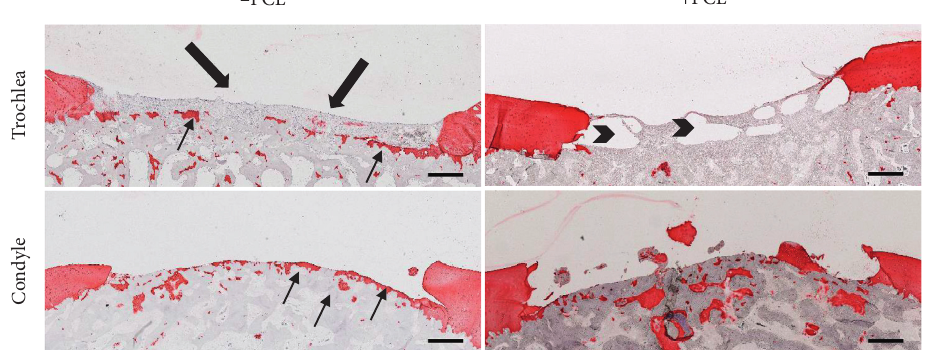
Figure 3: Insufficient construct retention in condylar and trochlea chondral defects with and without PCL-reinforcement. Collagen type II staining of exemplary depiction of one defect per group after 28 days. Both defects without PCL (left) showed a residual layer of cartilage (arrow). Fibrous tissue formed in one of the defects (big arrow). Fibrous tissue was retained in between PCL strands. Retained PCL- construct (arrowhead). Scale bar: 500 μ